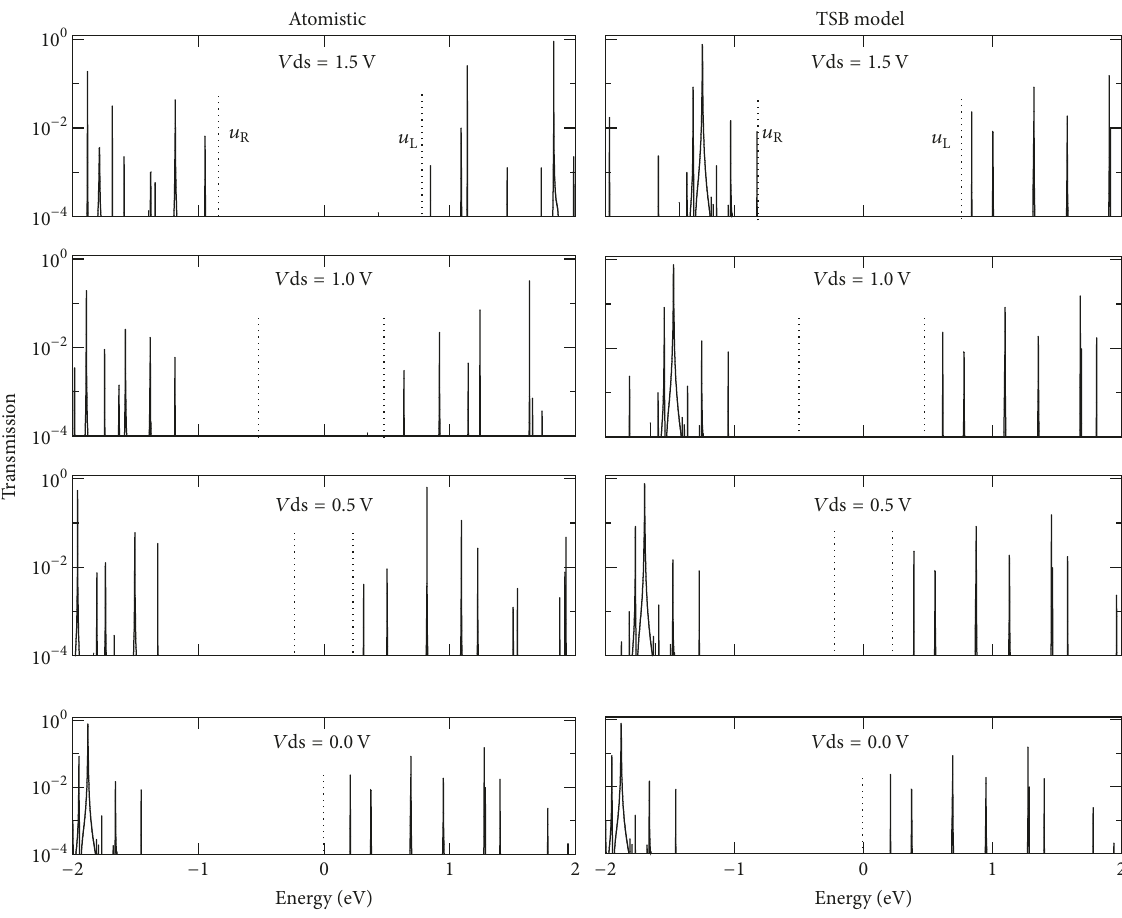
Figure 8: Transmission spectrum for different values of 𝑉 ds ( 𝑉 g = 0 ). The dotted lines represent the bias window. Transmission spectrum shifts to new energies when 𝑉 ds is changed. TSB model shows the same effect using self-consistent field loop. transistor the HOMO levels contribute to conduction. For the P-type device HOMO level should be near the Fermi